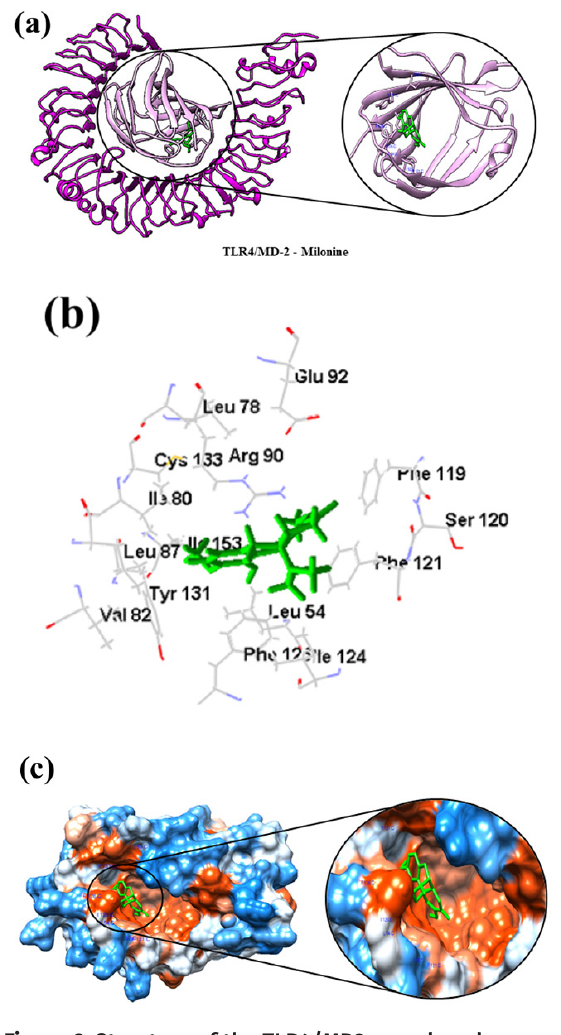
Figure 6. Structure of the TLR4/MD2 complexed with milonine. (a) General structure of the TLR4/ MD2-milonine complex. The TLR4 part is colored in dark lilac, the MD2 part is colored in light lilac, and milonine in green. (b) 3D interactions of the MD2 complex and milonine. (c) Representation of the surface of the MD2. Positively and negatively charged residues are colored in blue and orange,